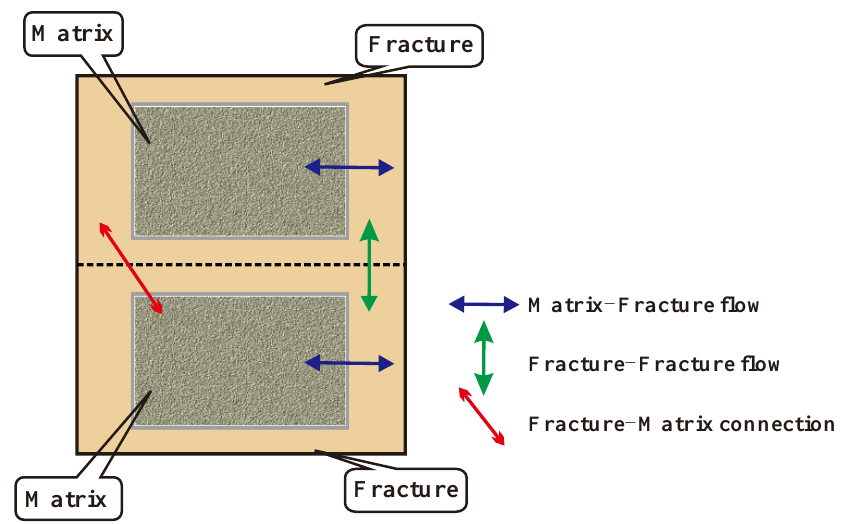
Figure 8. Natural fractures properties of modeling.